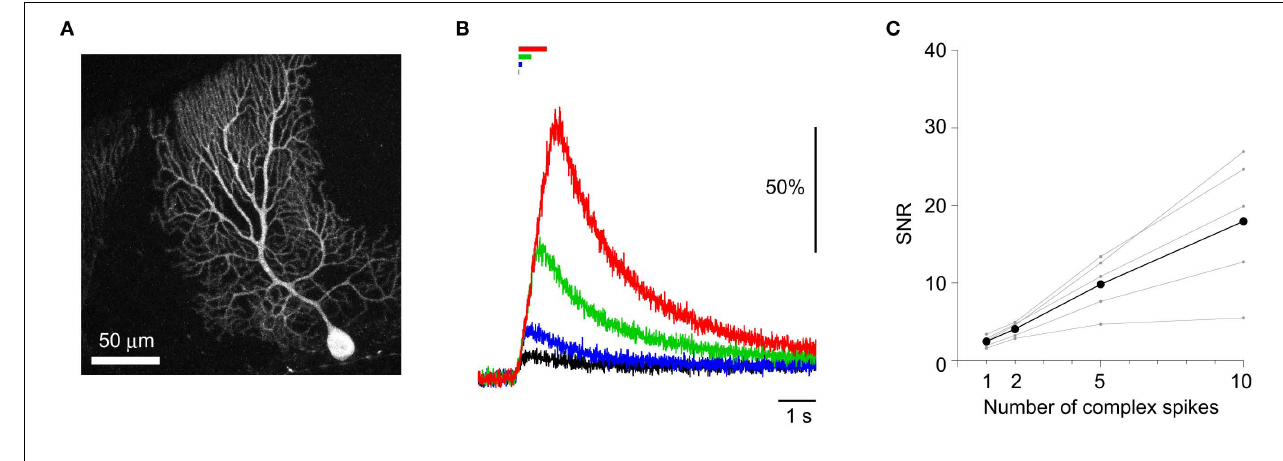
recorded fromYC2.60-expressing Purkinje cells at P113–114. Each trace is the mean across cells ( n = 5). (C) SNR plotted against the number of CSs, calculated for individual Purkinje cells (gray) and the mean across cells (black, n =